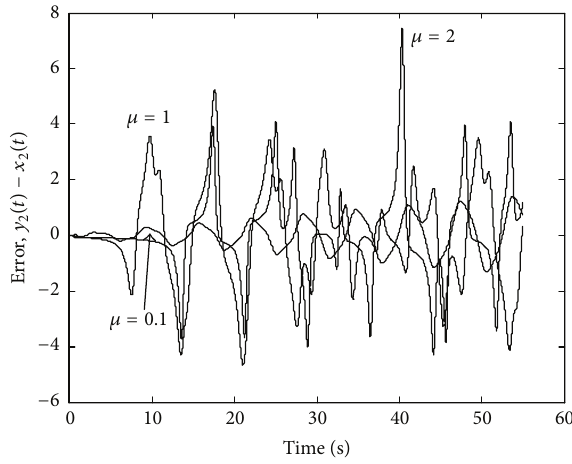
Figure 11: Stability of the limit cycle under increasing perturbations.